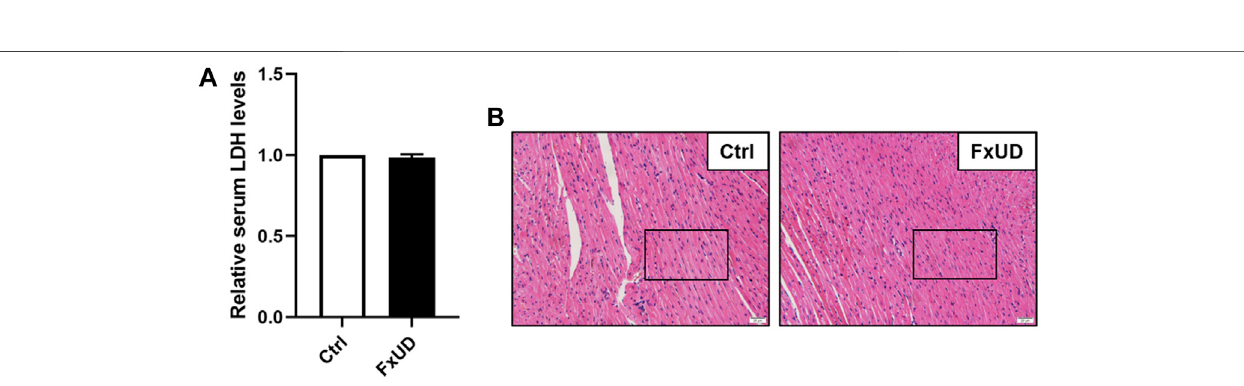
FIGURE 10 | The effect of FxUD on cardiovascular safety. (A) The serum LDH levels. (B) Cardiotoxicity was assessed by HE staining to determine the effect on heart, no signi fi cant histological changes were noted. Magni fi cation 200 × , scale bar 20 µm. Values are expressed as the means ± SD ( n (cid:1) 4). * p < 0.05 vs. Ctrl.